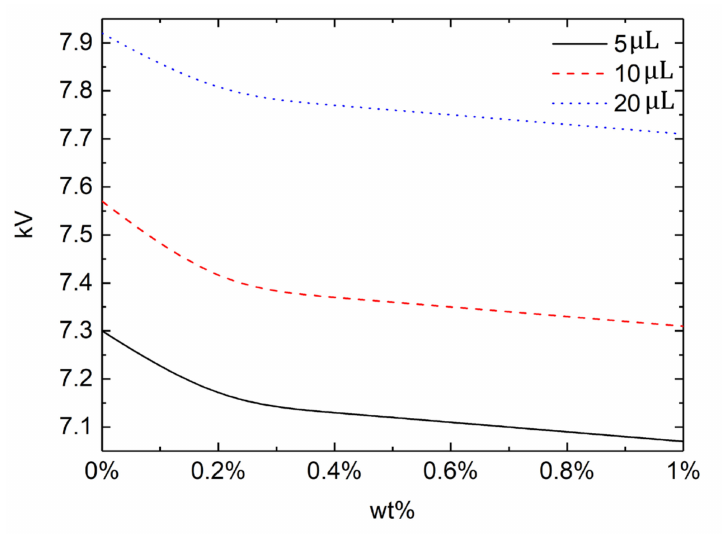
Figure 9. Critical voltage for the take-off phenomenon against PEO concentration for three different droplet